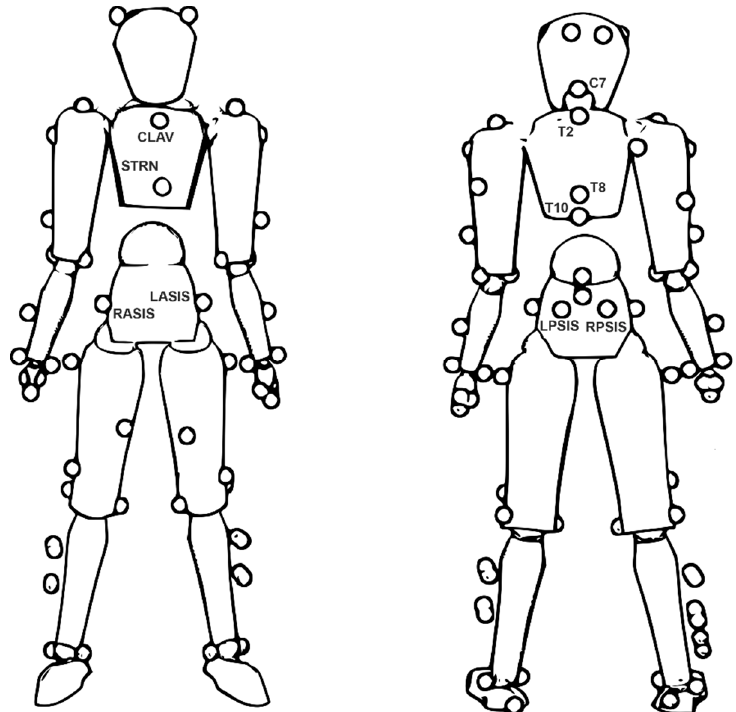
Figure 2. Whole body golfer model and marker locations. Labelled markers were used to track the pelvis and thorax segments.